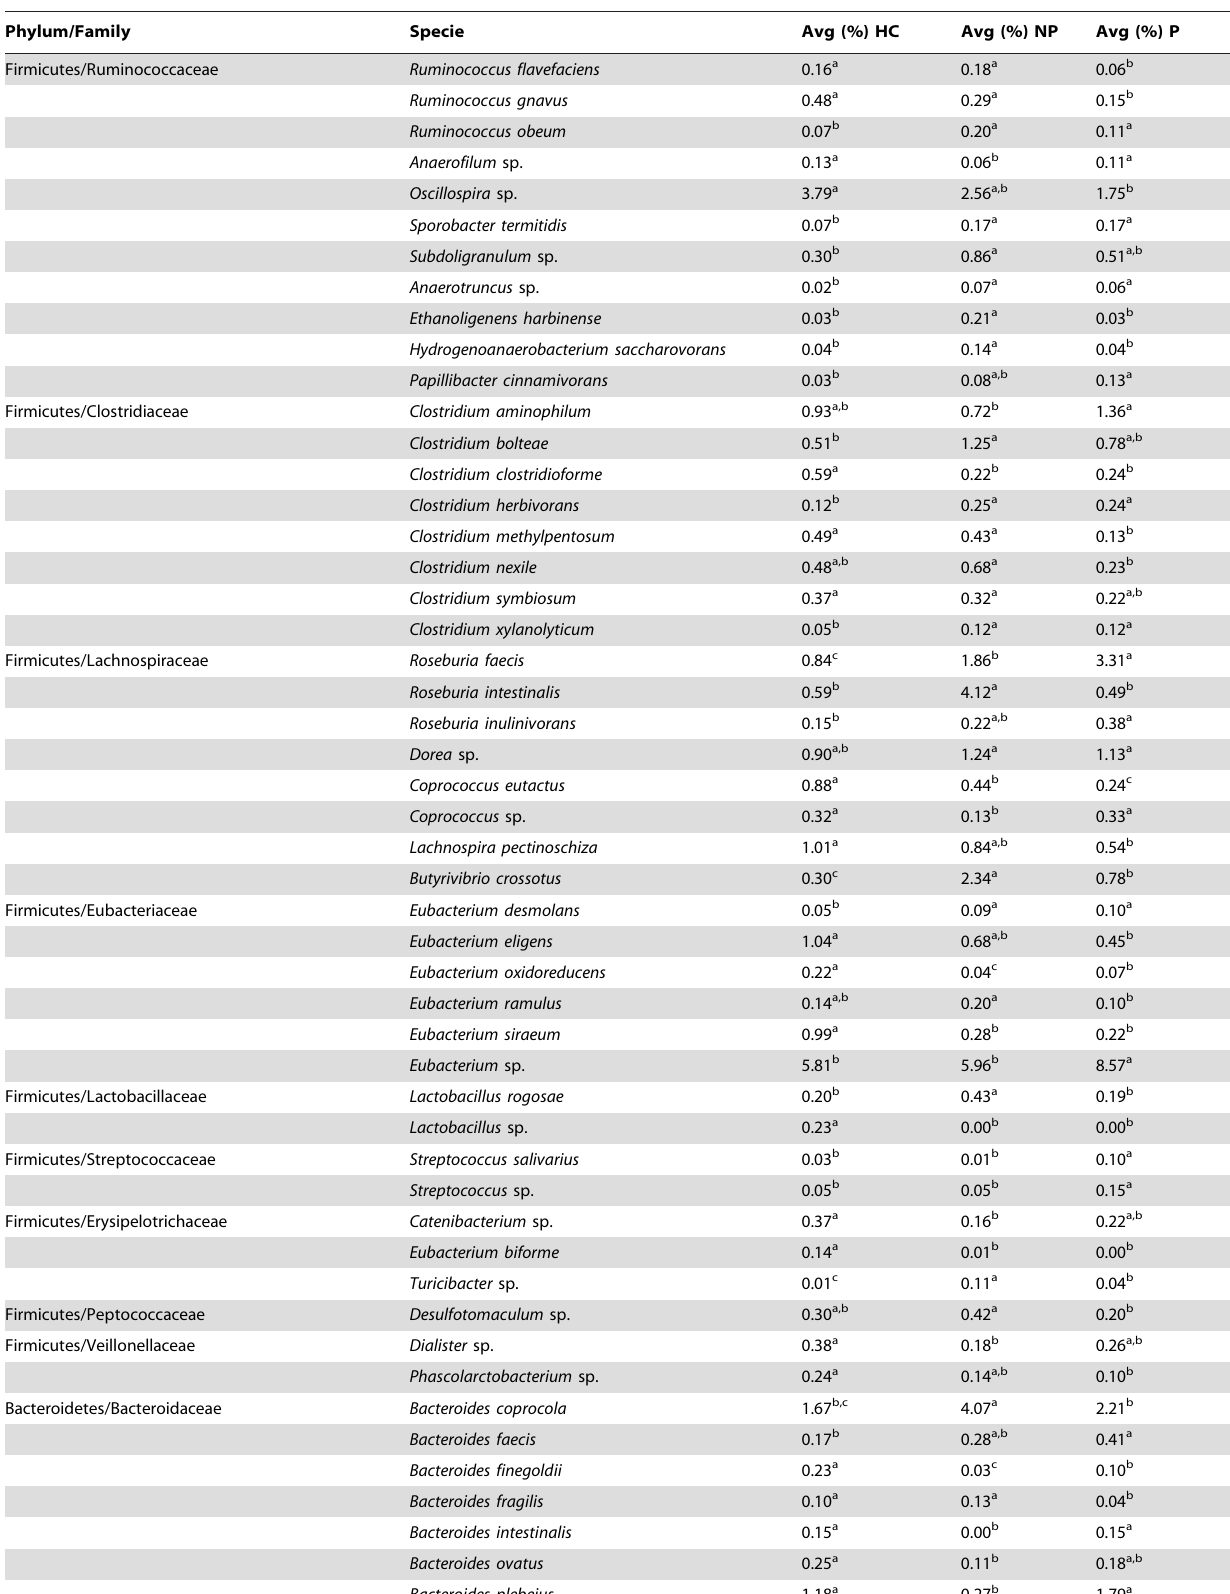
Table 3. Immunoglobulin A nephropathy (IgAN) associated microbiome.